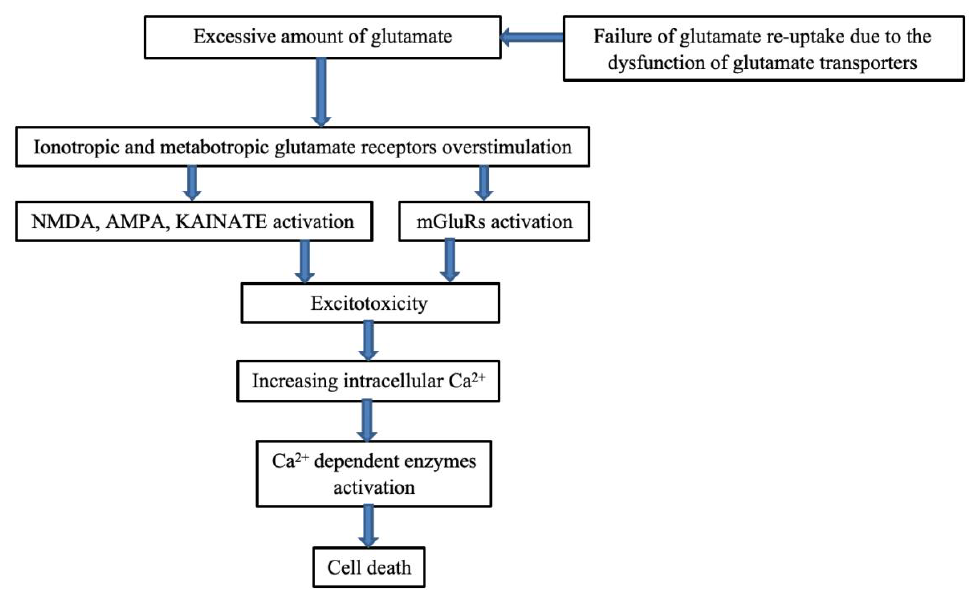
Figure 4. Glutamate excitotoxicity. A schematic of the mechanism of cell death triggered by excessive glutamate release.